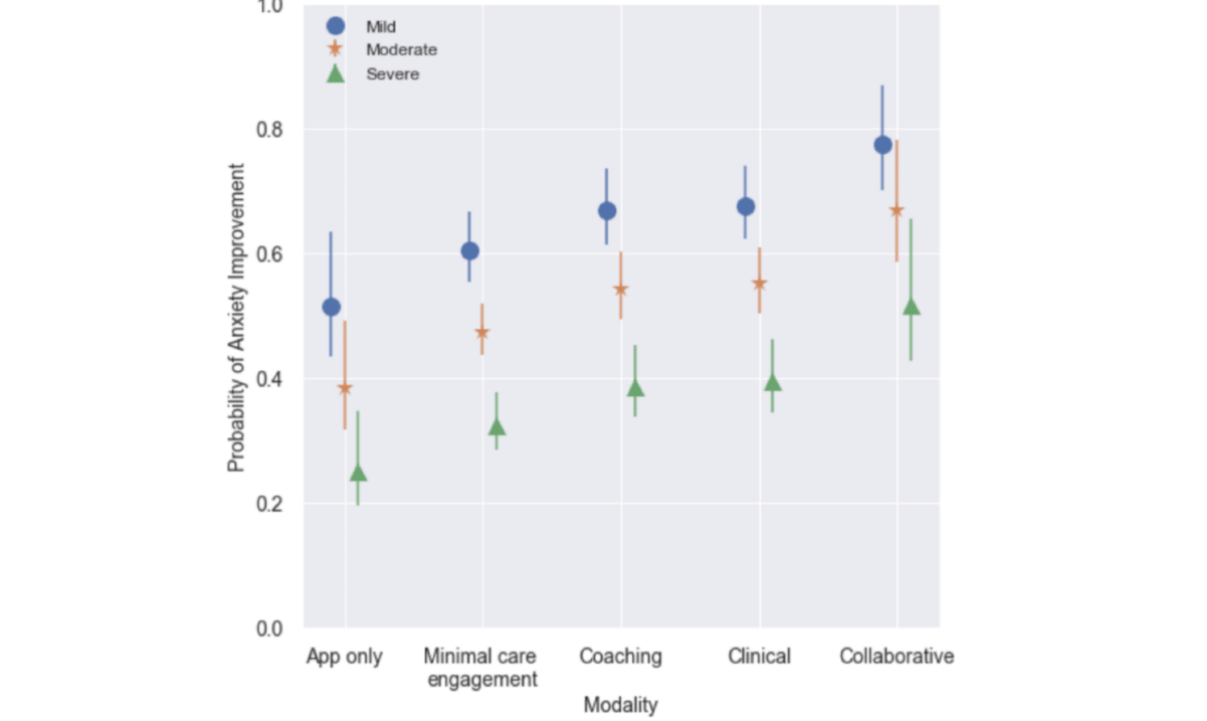
Figure 1. Probability of anxiety improvement by care modality and level of intake severity. Shapes represent the expected mean probability of improvement by modality and intake severity; lines represent the corresponding 95% confidence interval.